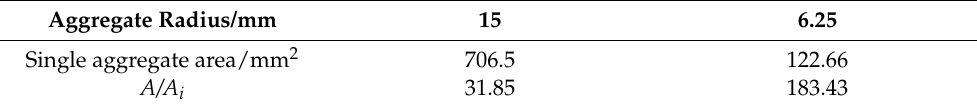
Table 2. Ratio of specimen area to aggregate